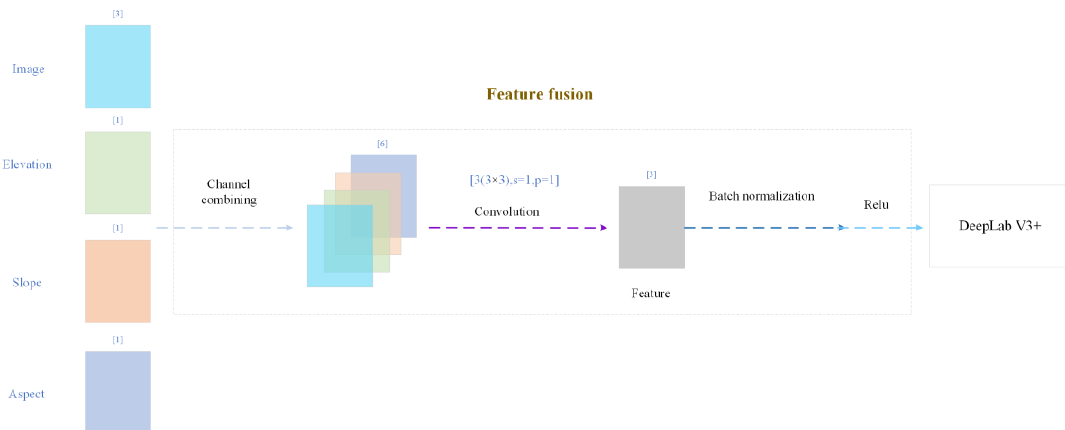
Figure 4. Feature fusion